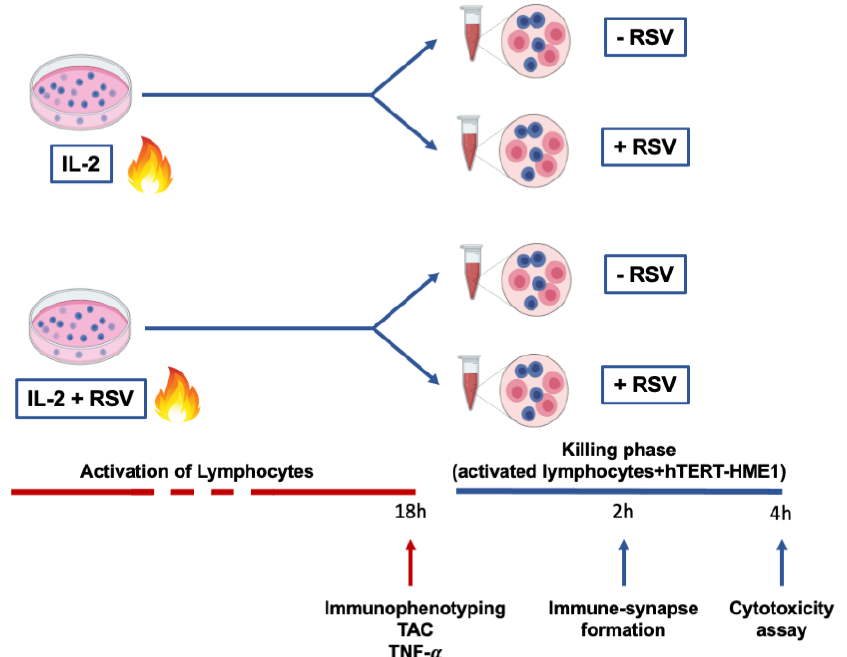
Figure 1. Experimental design. Lymphocytes were activated by IL-2 treatment for 18 h. At the end of the activation phase, immunophenotyping, TAC, and TNF- α production were evaluated. To analyze the effector phase, cells were then co-cultured with premalignant hTERT-HME1 cells for 4 h, and both immune synapse formation and cytotoxicity were analyzed. The blue cells in the figure represent lymphocytes, while the pink cells refer to